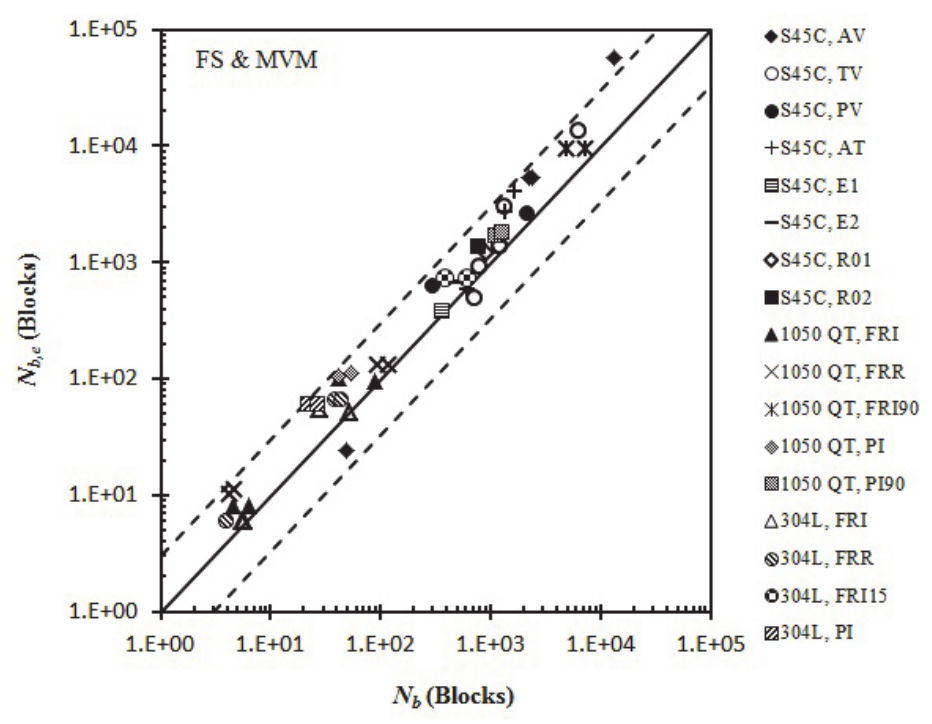
Figure 6: Comparison of observed and predicted fatigue lives by Procedure B